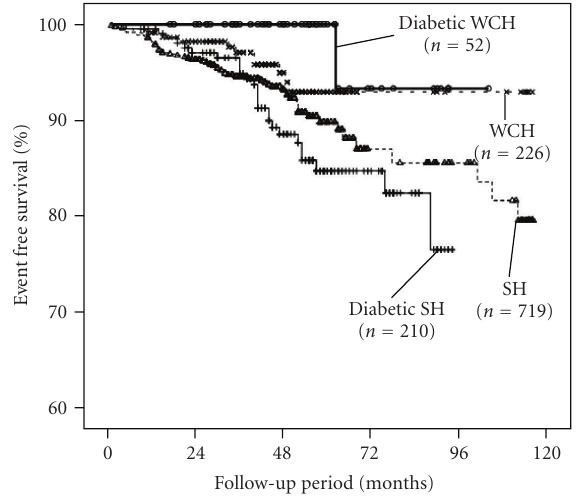
Figure 7: Curves for event-free survival without a cardiovascular event. The overall log-rank statistic for the 4-group comparison was 8.8 ( P = . 032). The log-rank statistics for the intergroup comparisons were 4.9 ( P = . 028; diabetic SH versus diabetic WCH), 2.08 ( P = . 15; diabetic SH versus SH), and 5.1 ( P = . 024; diabetic SH versus WCH). However, the value in the diabetic WCH group was not significantly di ff erent from that in the SH group ( χ 2 = 3 . 0, P = . 08) or WCH group ( χ 2 = 1 . 2, P = . 28) and that in the SH group was not significantly di ff erent from that in the WCH group ( χ 2 = 2 . 2, P = . 14). SH, sustained hypertension; WCH, white-coat hypertension (Adopted from